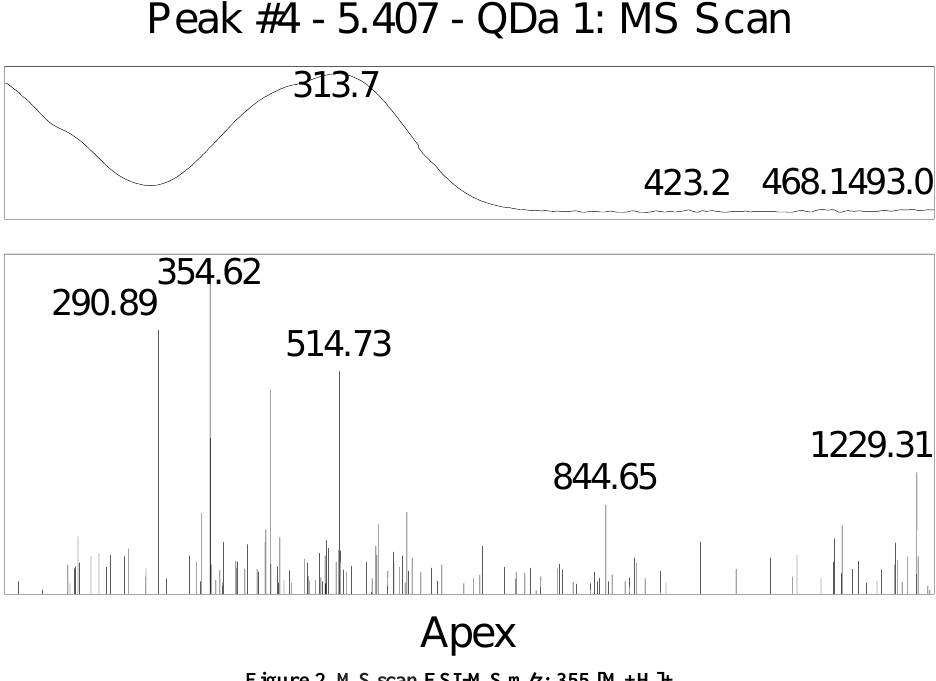
Figure 2. MS scan ESI-MS m/z: 355 [M+H]+ The substance 2 - (Figure 2) is retention time 5.407 min, ʎ max 313.7 nm (Table 2); In positive ionization mode, substance 2 mainly showed molecular ions ESI-MS m/z: 355.26 [M + H]+; according to the obtained results and compounds mass database METLIN (https://metlin.scripps.edu) the substance 2 was identified as –